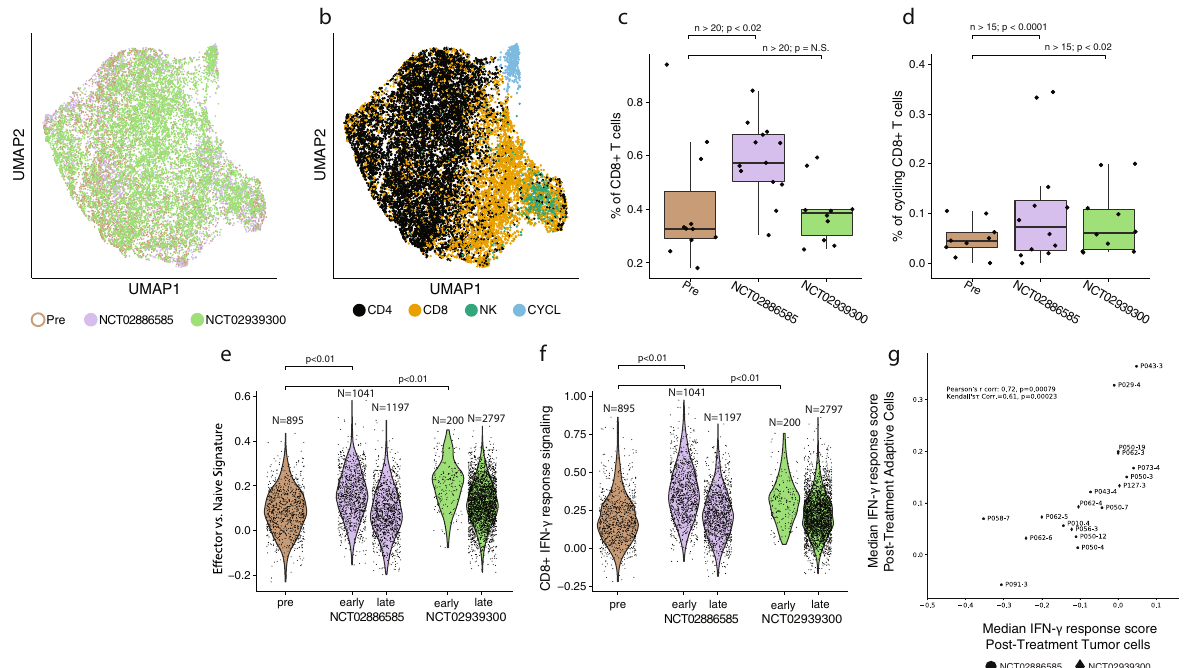
Fig. 2 T cells in CSF exhibit strong differences in the expression of interferon-induced, cytotoxic, and exhaustion genes following ICI. a , b UMAP calculated over all T/NK cells ( n = 16,954), colored by cohort ( a ) and canonical cell type ( b ) as identi fi ed via iterative subclustering (see Methods). c Percentage of CD8 + T Cells in pre-treatment, post-treatment cohort 1, and post-treatment cohort 2 samples; only samples with more than 20 T cells considered. d Proportion of CD8 + T cell cycling in pre-treatment, post-treatment cohort 1, and post-treatment cohort 2; only samples with more than 10 CD8 + T cells considered. e Effector vs naïve gene expression in pre-treatment, early post-treatment (<30 days post-treatment), and late